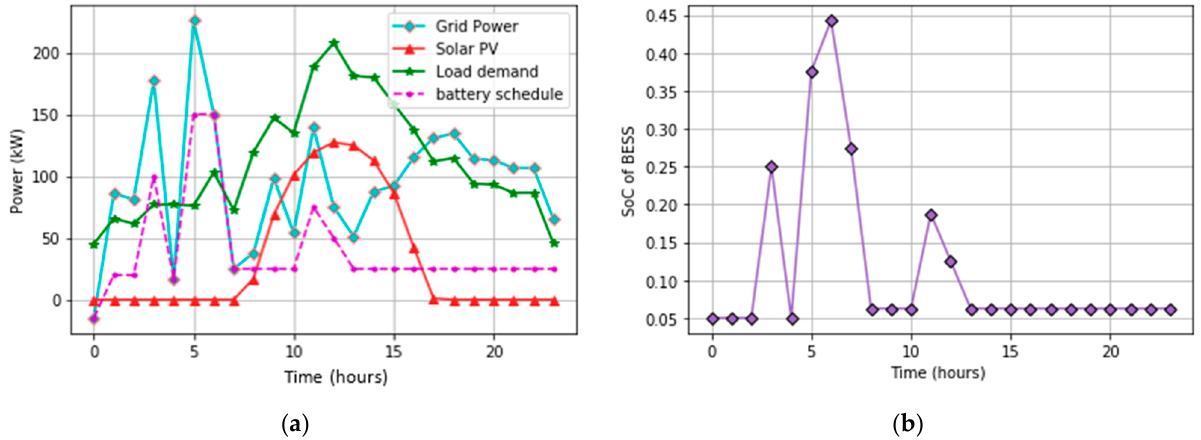
Figure 8. Observations without grid constraint; ( a ) Optimized energy schedule. ( b ) Tendency of the SoC of the BESS.